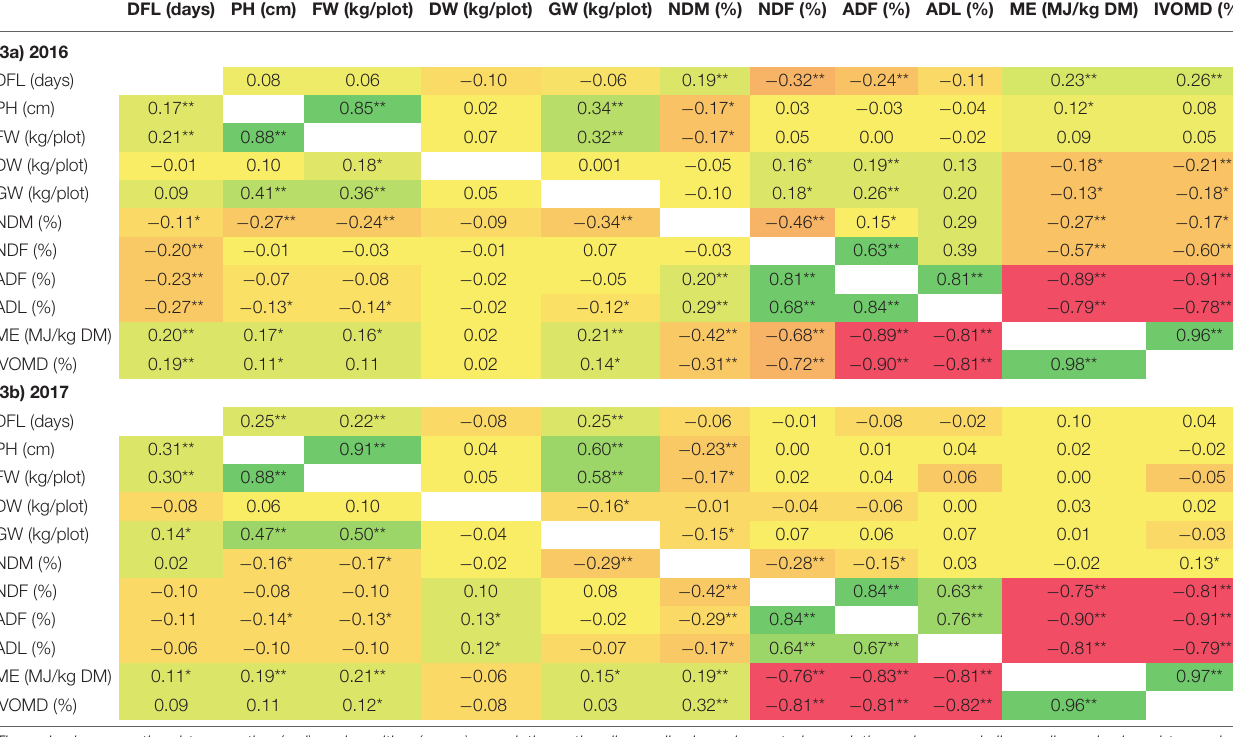
TABLE 3 | Correlation of agronomic and fodder quality under drought, (3a) for year 2016 (3b) for year 2017, diagonally; the upper side represents control, and the lower side is